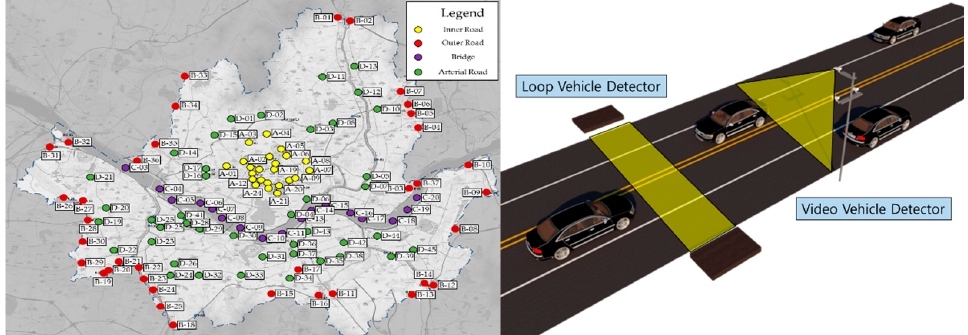
Figure 3. Location and collection method of traffic detectors in Seoul. Due to the limitations of detectors’ collection space and accuracy, until now, the total traffic volume of a city was predicted using loop detector data and studies aiming to improve the accuracy were conducted